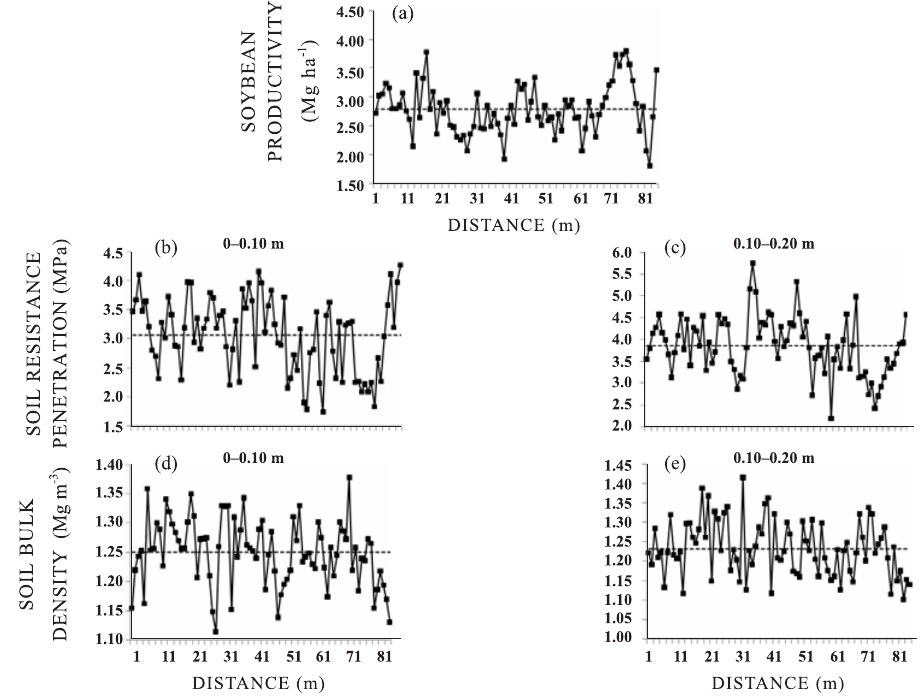
Figure 1. Data spatial distributions of all observed variables along the transect of 84 sampling points: (a) soybean yield; (b) soil penetration resistance in the 0–0.10 m layer; (c) soil penetration resistance in the 0.10–0.20 m layer; (d) soil bulk density in the 0–0.10 m layer; and (e) soil bulk density in the 0.10–0.20 m layer.